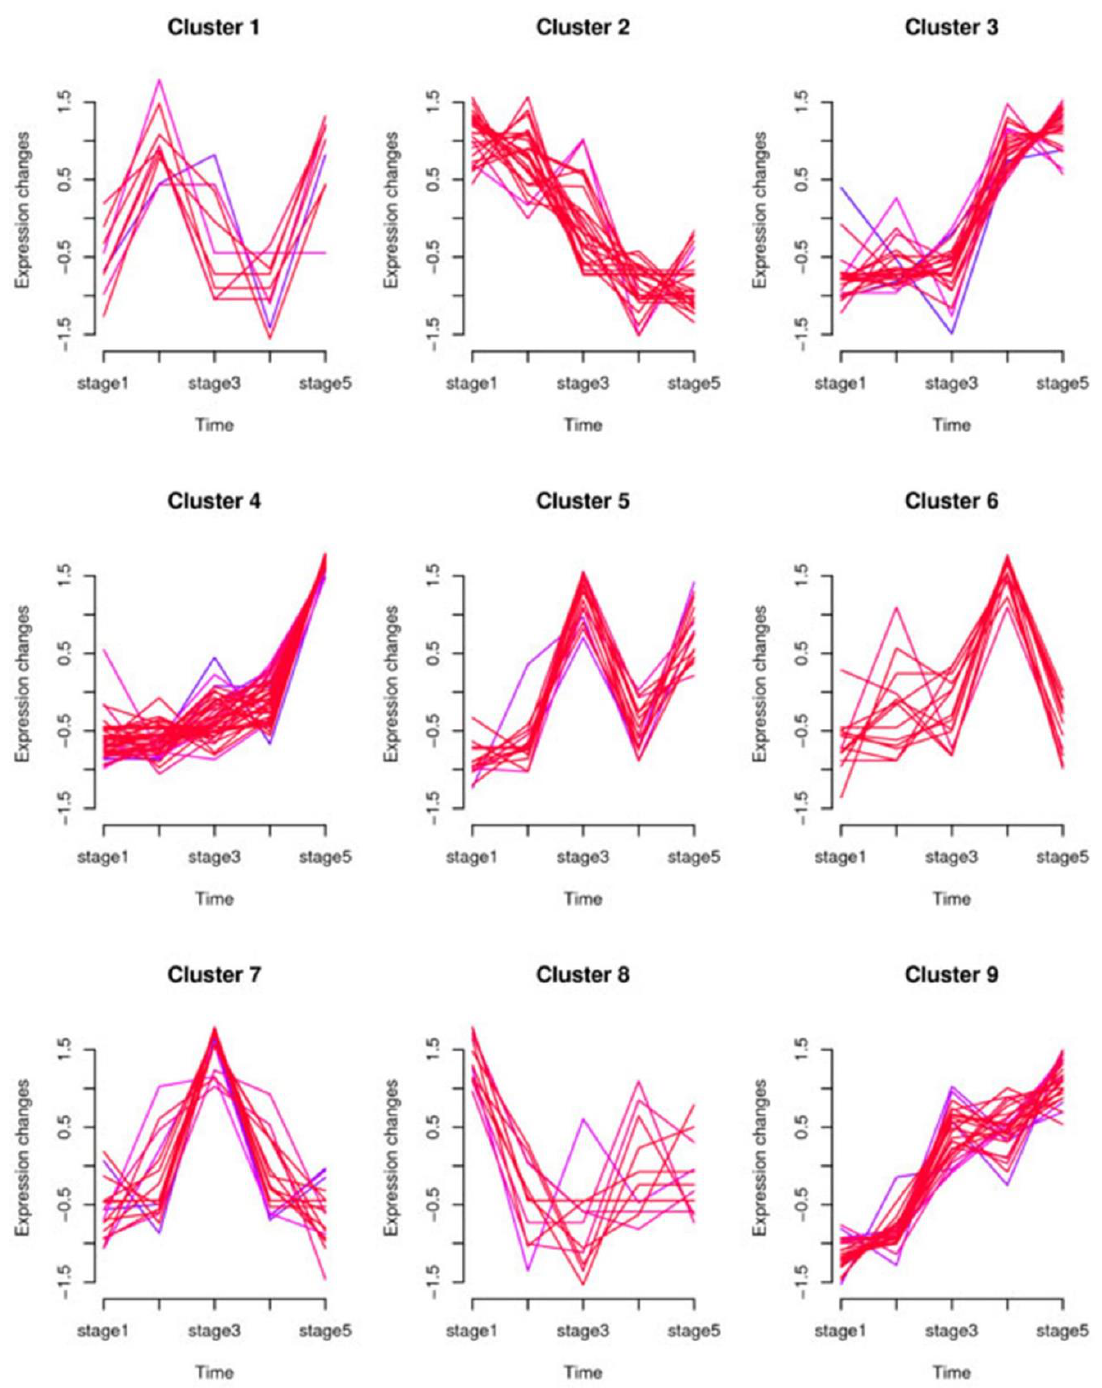
Figure 3. Temporal expression patterns of miRNAs in the five development stages of the receptacle. All miRNAs were classified into nine clusters based on their expression patterns using the Mfuzz R package.